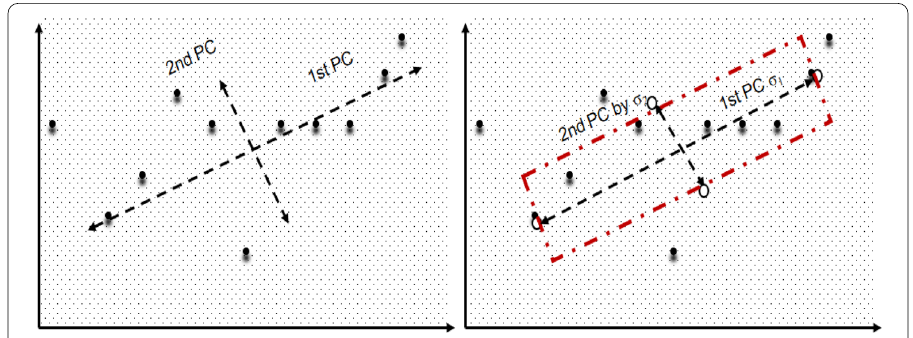
Fig. 6 Bounded principal